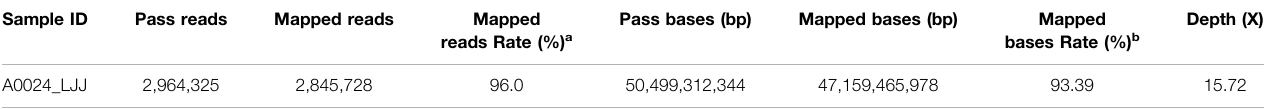
TABLE 1 | Summary of the aligned sequences. Sample